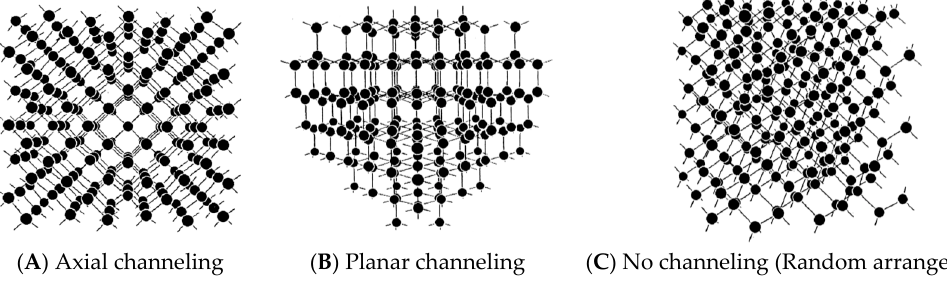
Figure 15. Illustrations to show the different appearance of a crystal lattice by the view angle [26].